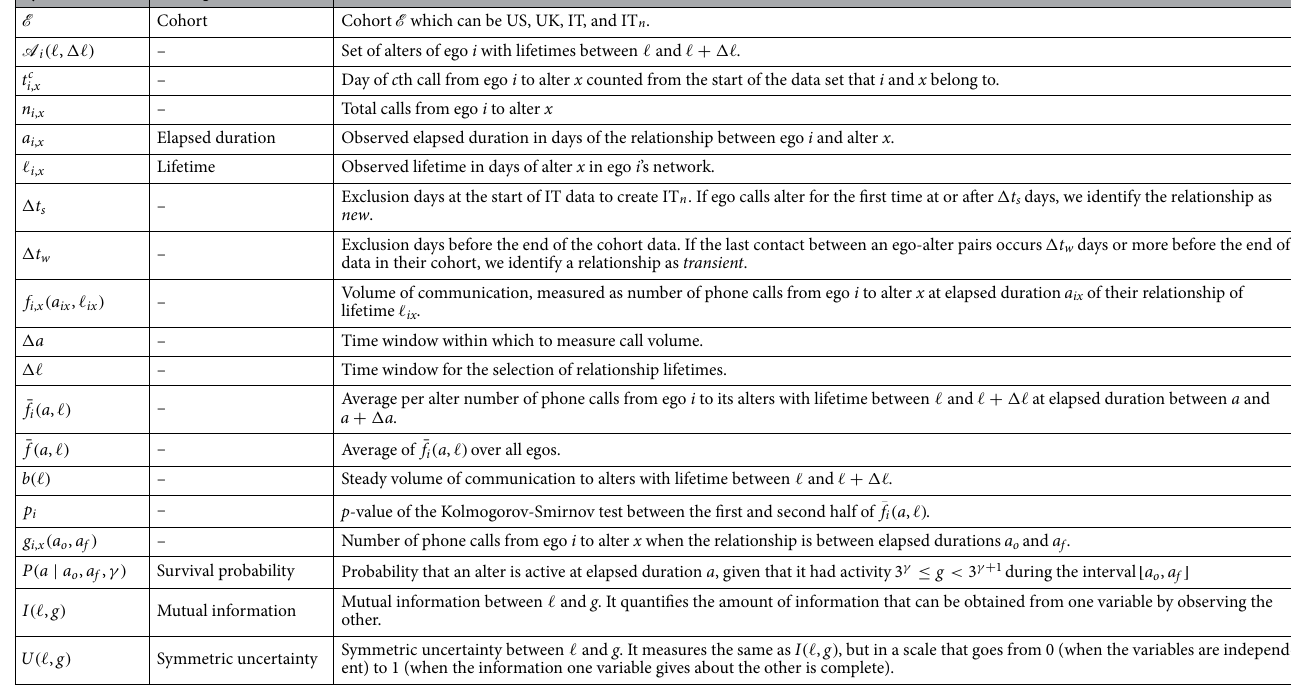
Table 1. All symbols used in this paper, both in the main text and SI. Next to each symbol, there is a brief